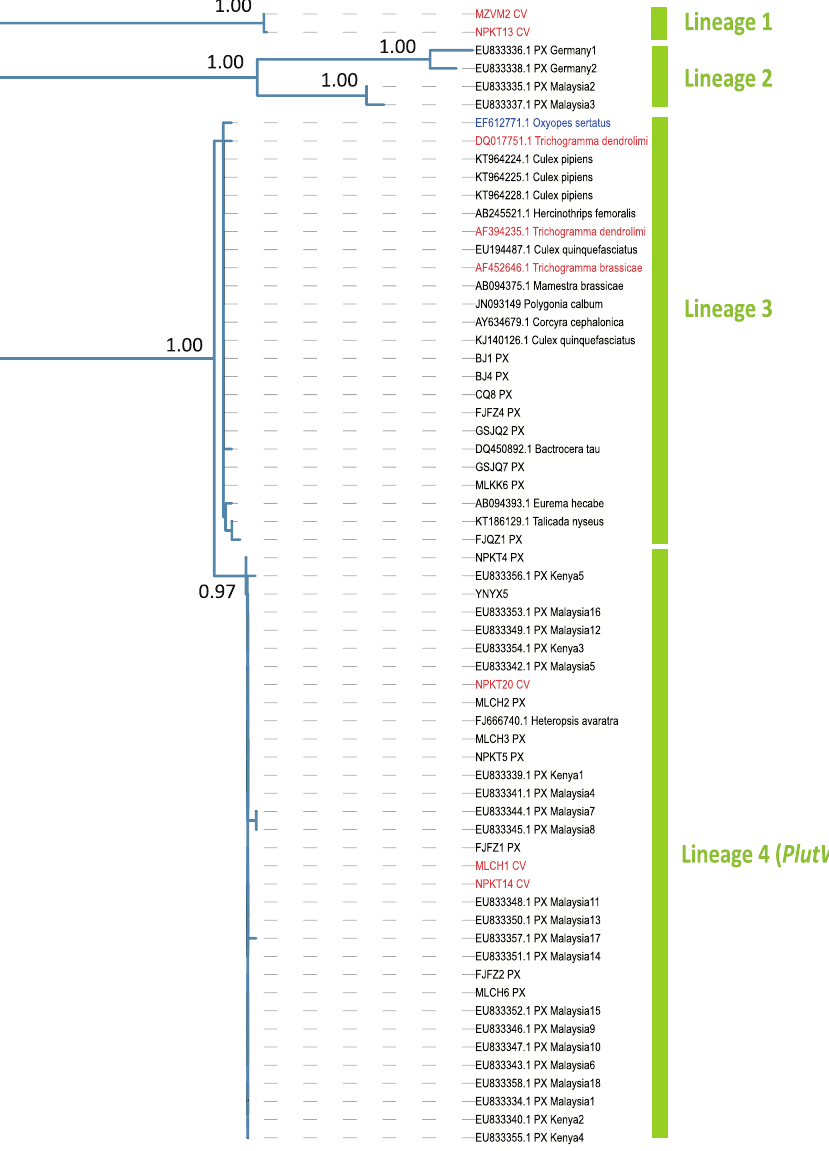
Figure 3. The Wsp -based Phylogenetic Tree of Wolbachia . The gene sequences are coloured for different hosts (black: herbivore; red: parasitoid; blue: predator). PX = P. xylostella ; CV = C. vestalis . Numbers upon branches are bootstrap values >